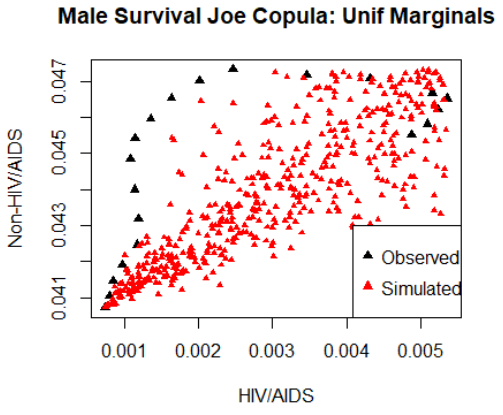
Figure 10. Uniform marginal distribution for males.